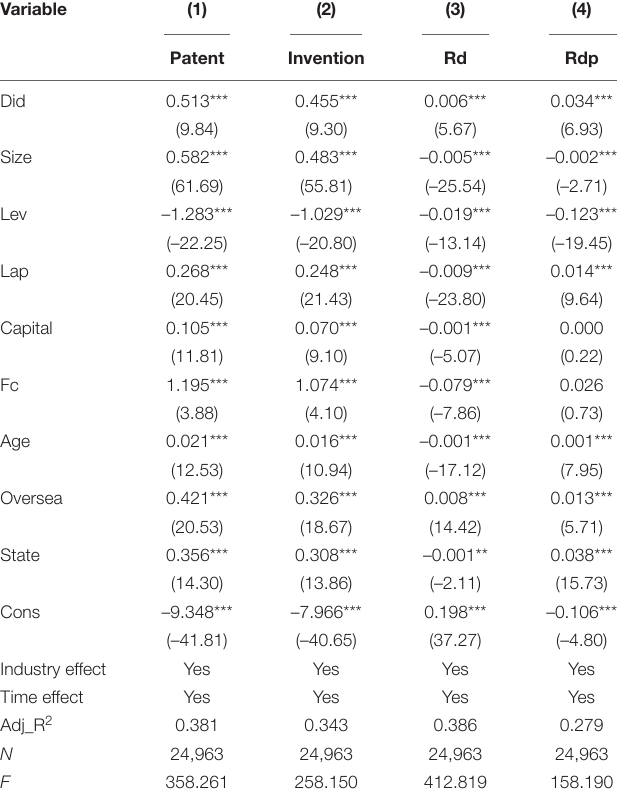
TABLE 7 | Dynamic effect regression